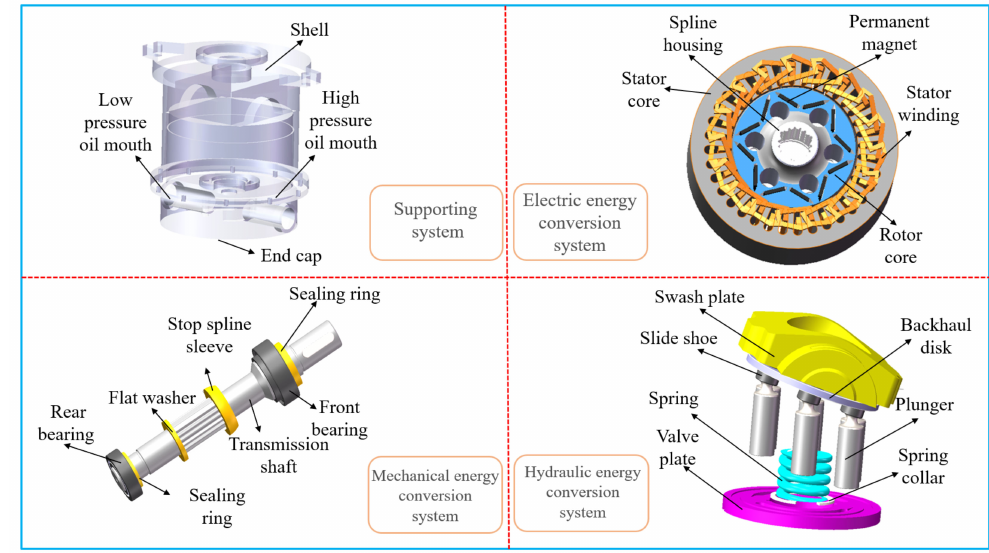
Figure 1. Four major system structures of the mechanical-electric-hydraulic dynamic coupling drive system